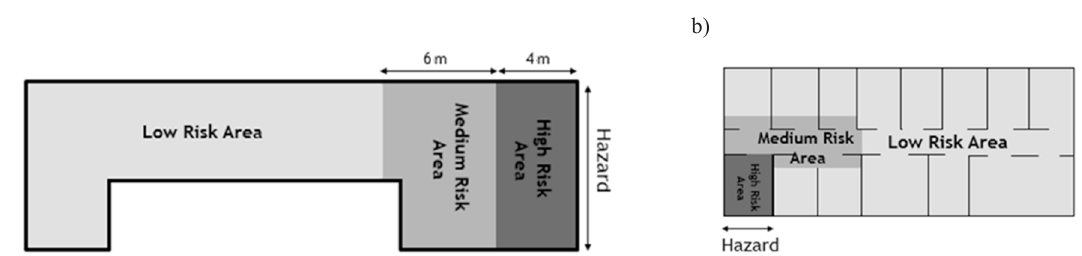
Fig. 4. Definition of hazard areas in the simulation